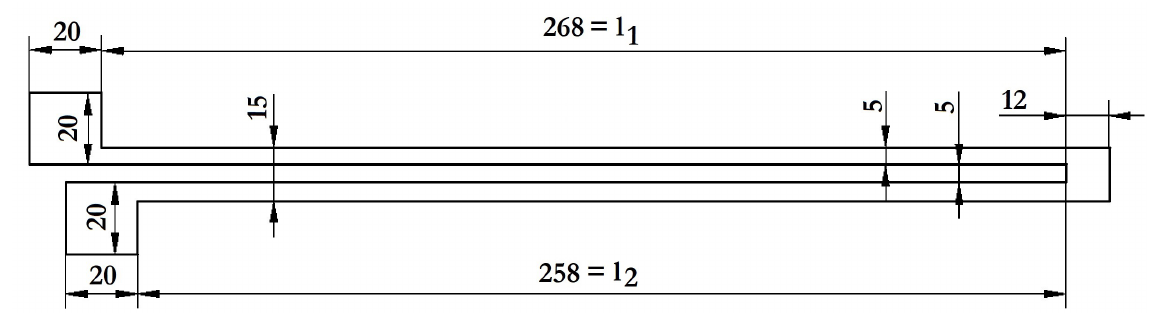
Figure 14. Geometric parameters of a U-shaped elastic beam.